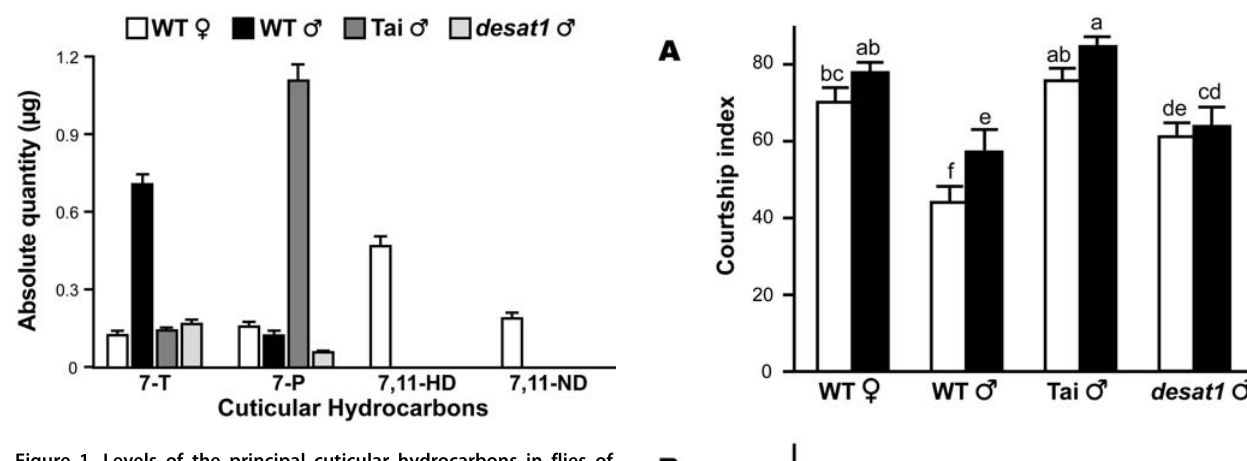
Figure 1. Levels of the principal cuticular hydrocarbons in flies of various genotypes. Data shown represent the mean ( 6 sem) for absolute amount of the principal hydrocarbons detected on the cuticle of 5-day-old flies. 7-T= Z -7-tricosene; 7-P= Z -7-pentacosene; 7-11 HD= Z-Z -7,11-heptacosadiene; 7-11 ND= Z-Z -7,11-nonacosadiene. The genotypes shown correspond to the target flies tested either with a WT male or with a Gr66a-Gal4 /WT male (see Fig. 2A). WT=Canton-S strain.